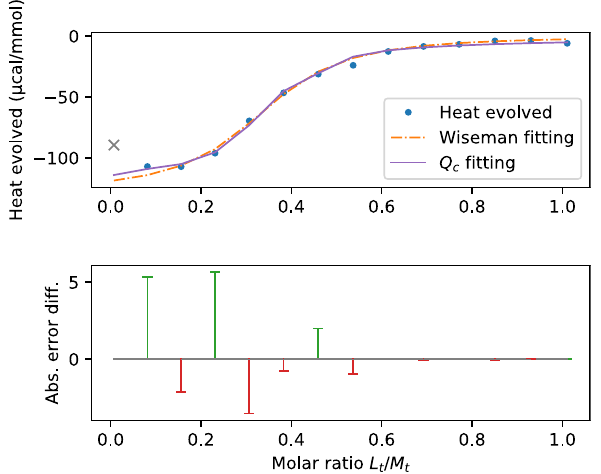
Figure 4. ( a ) Integrated heat per injection over molar ratio with Wiseman graphs of Wiseman and Q c fitting for the trivalent case. ( b ) Difference of absolute error plots from Wiseman and Q c fitting. Calculated with a Gaussian distribution to apply weight around the